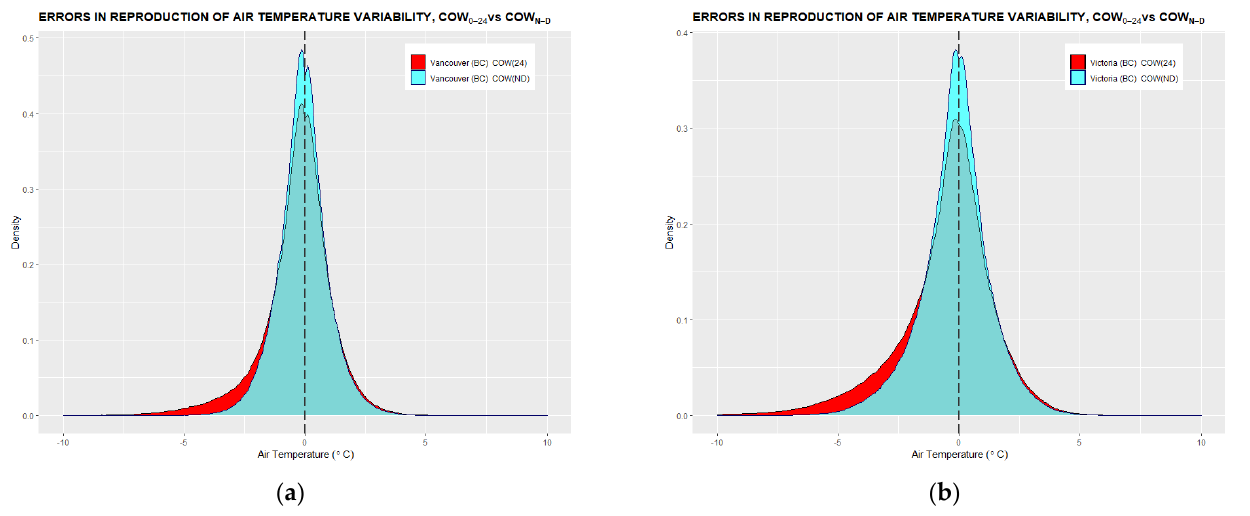
Figure A1. Pacific Coast climate region. Histograms of conformity of COW 0–24 and COW N–D reproduced temperature with observed hourly temperature data for the 1953–2018 data period at Vancouver ( a ) and Victoria ( b ) stations.